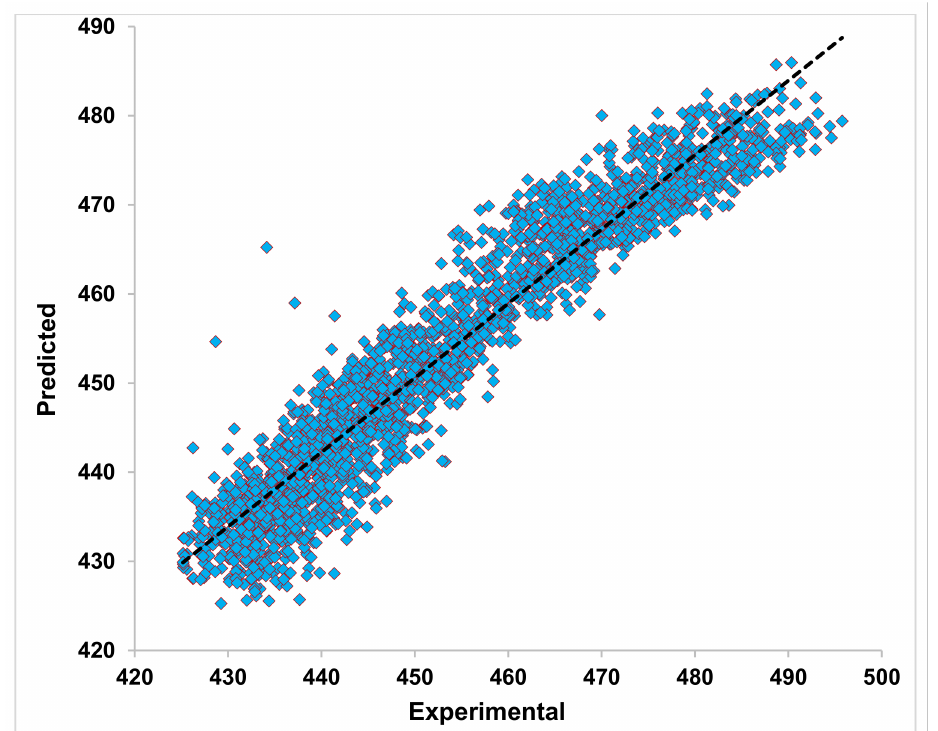
Figure 10. Testing predictions from Linear regressor and experimental output plotted along a line where the R 2 is 0.907 from the trendline.